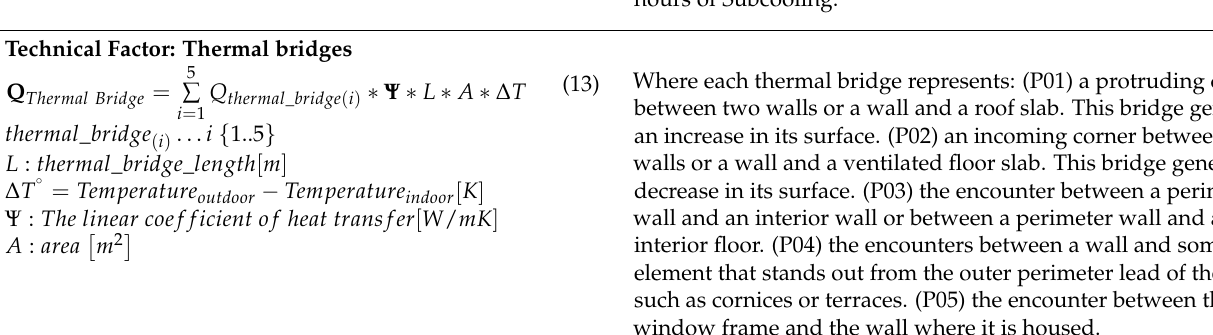
window frame and the wall where it is